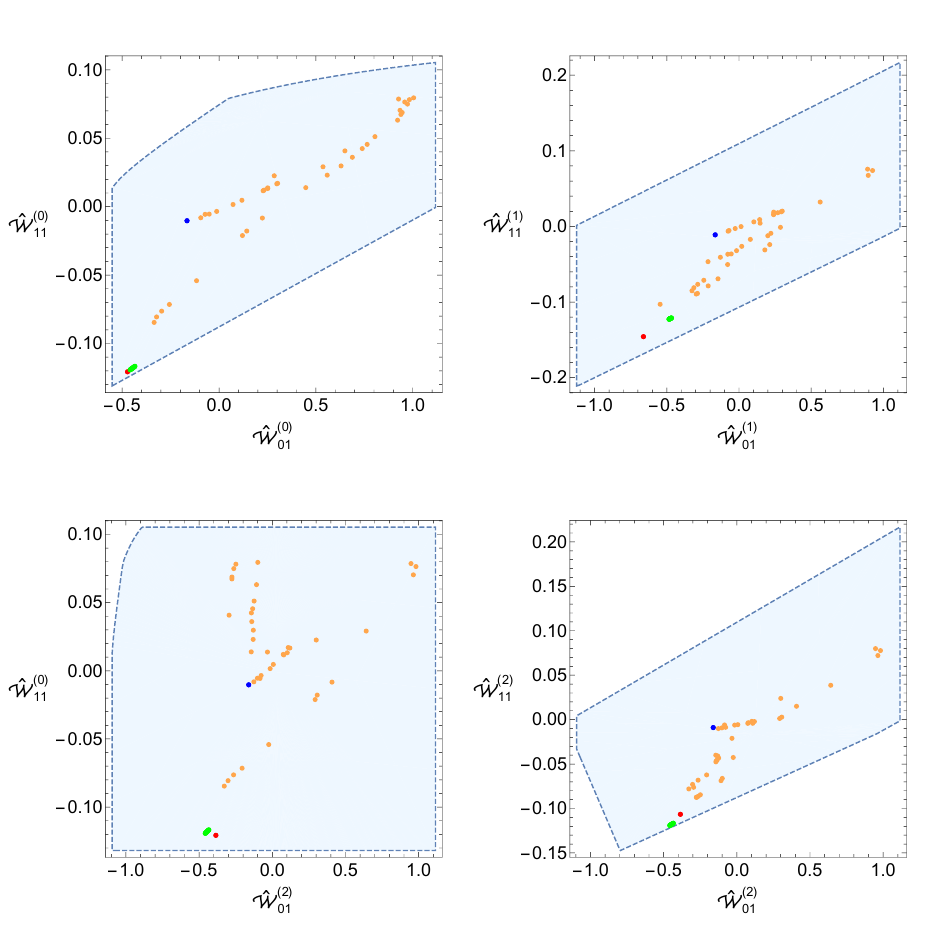
Figure 1 . The light blue region is the theory space allowed by positivity and typically real- ness. Some of the known theories has been indicated. Green region is the O (3) Lovelace-Shapiro model (A.1) with β 0 = 1 (1 − β ) and β varies from 0 . 465 < β 0 . 489 (see [36]). The red dot 0 0 0 < m 2 ρ is the O (3) Lovelace-Shapiro model (A.1) with β = β 0 = 1 / 2 . The blue dot is the 2-loop chiral 0 perturbation theory with parameters are taken from experimental values. The orange regions are obtained from the S-matrix bootstrap amplitude for the upper river boundaries [36,